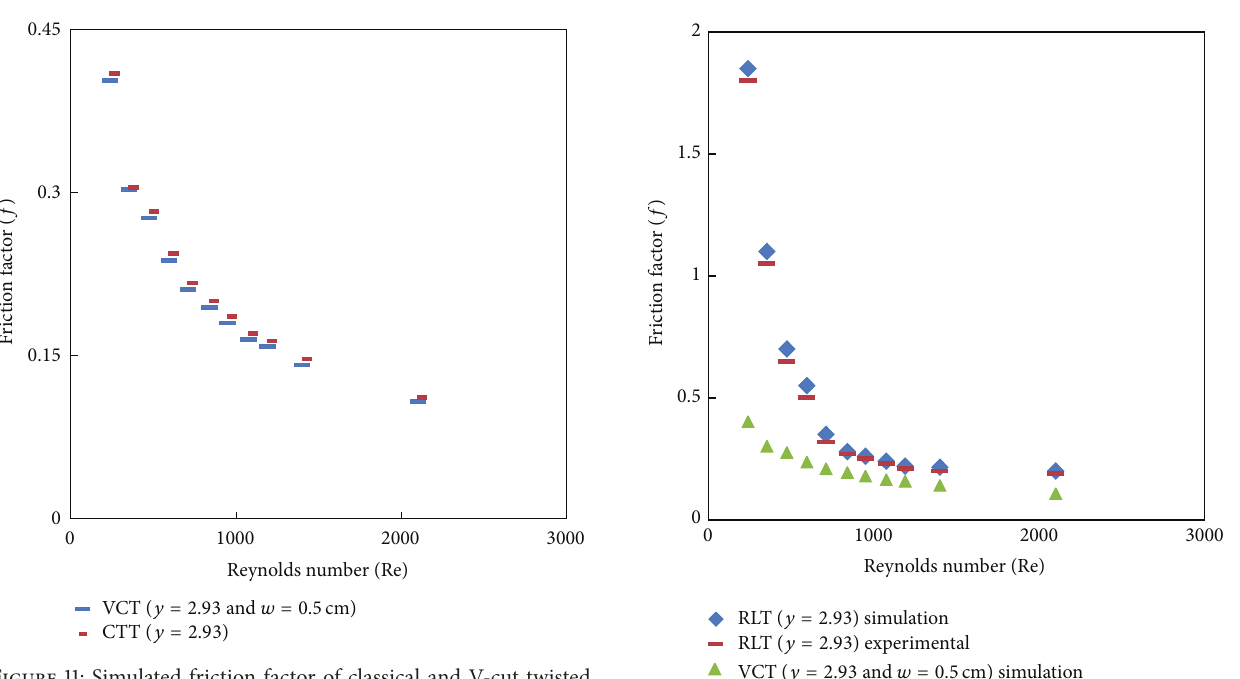
Figure 11: Simulated friction factor of classical and V-cut twisted tape inserts ( 𝑦 = 2.93 ) with cut depth 𝑤 = 0.5 cm.